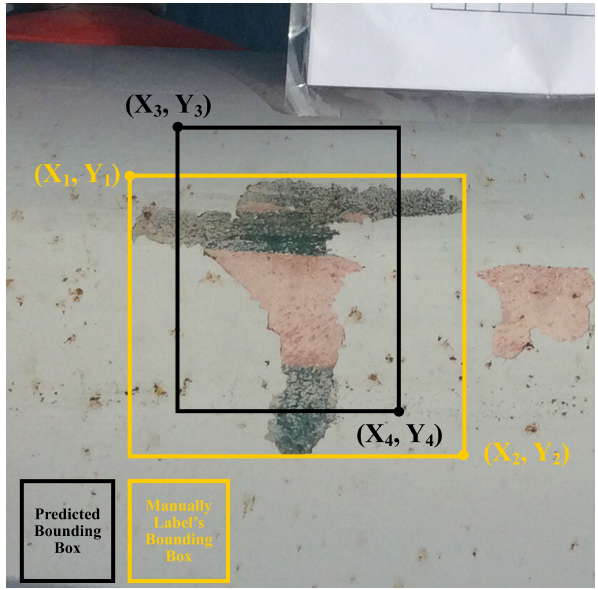
Figure 1. Bounding Box Accuracy—yellow box shows the bounding box of the manually labelled de- fect, and the black box is an example predicted bounding box that may be generated by the detection model. BBA computes the difference between two overlapping bounding boxes by calculating the area between the overlapping boxes. If there is no overlap between the bounding boxes, the BBA value will be